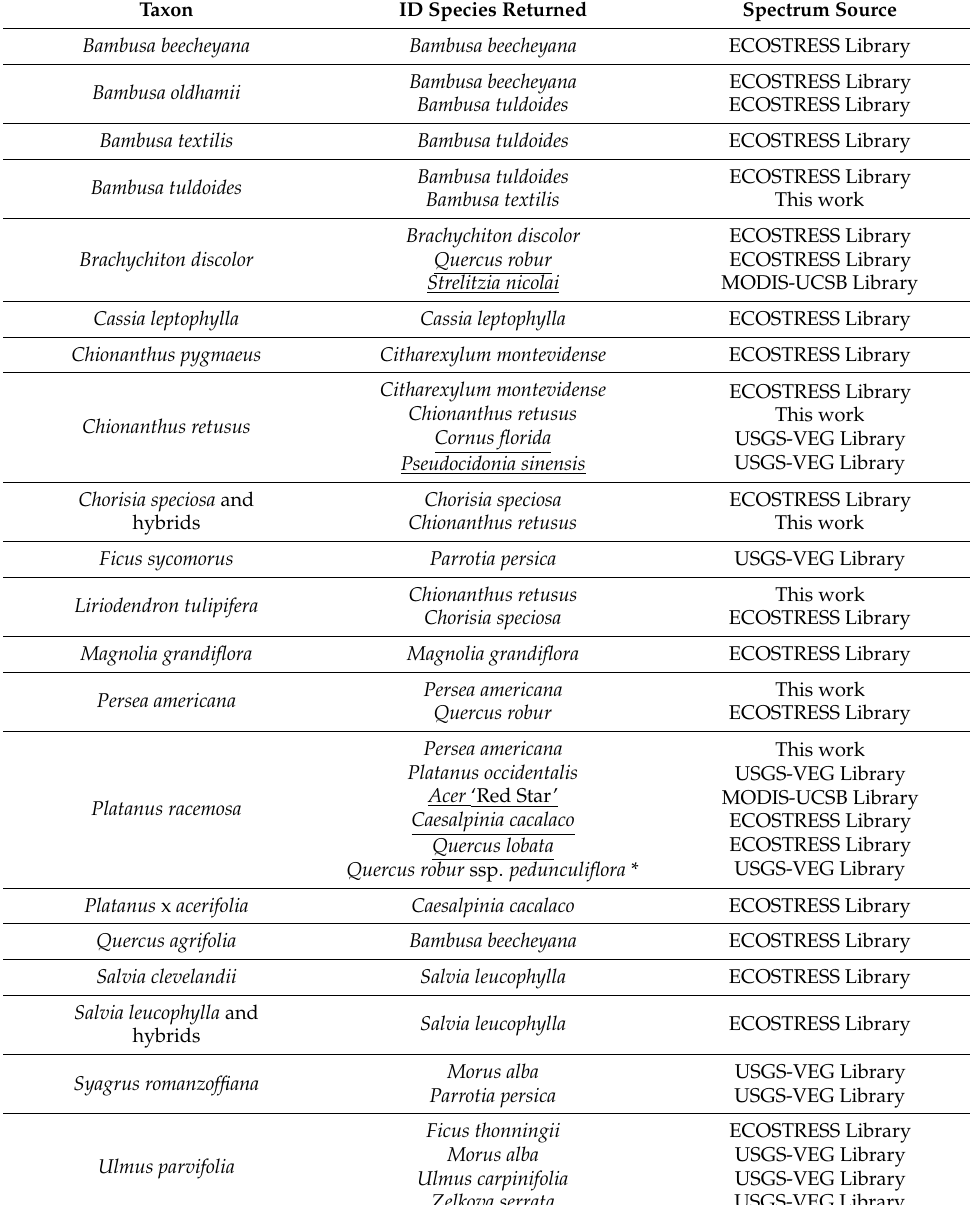
Table 4. Reference spectra commonly associated with the most frequently ID’d